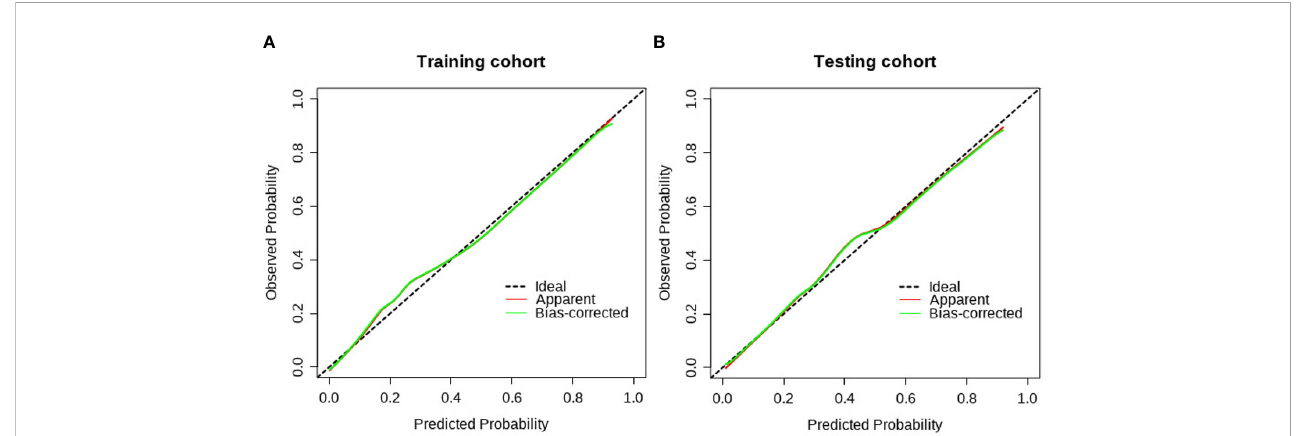
FIGURE 5 The calibration curve of the clinical radiomics model. (A) The calibration plot also showed good agreement between the transition probabilities predicted by the nomogram in the training cohort; (B) The calibration plot also showed good agreement in the testing